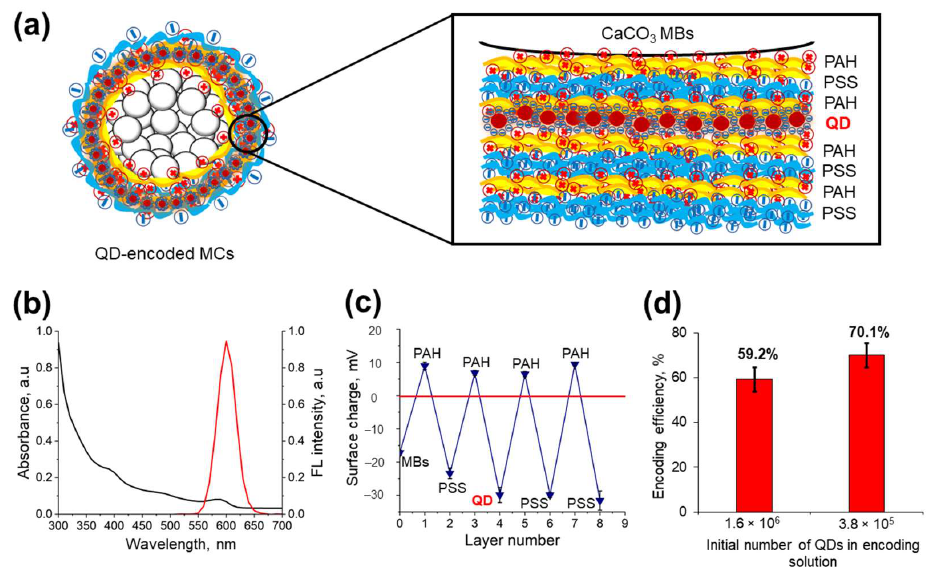
Figure 4. Obtaining microcapsules optically encoded with quantum dots (QDs). ( a ) A schematic diagram of the arrangement of the QD and PAH/PSS layers in the polyelectrolyte shell. ( b ) Optical characteristics of the CdSe/ZnS core/shell QDs solubilized with a PEG derivative (HS-(PEG) 12 - COOH). ( c ) Changes in the ζ-potential of the microbead/microcapsule surface upon application of the PAH/PSS polyelectrolytes and QD layers. ( d ) Estimated efficiency of the optical encoding of the microcapsules.